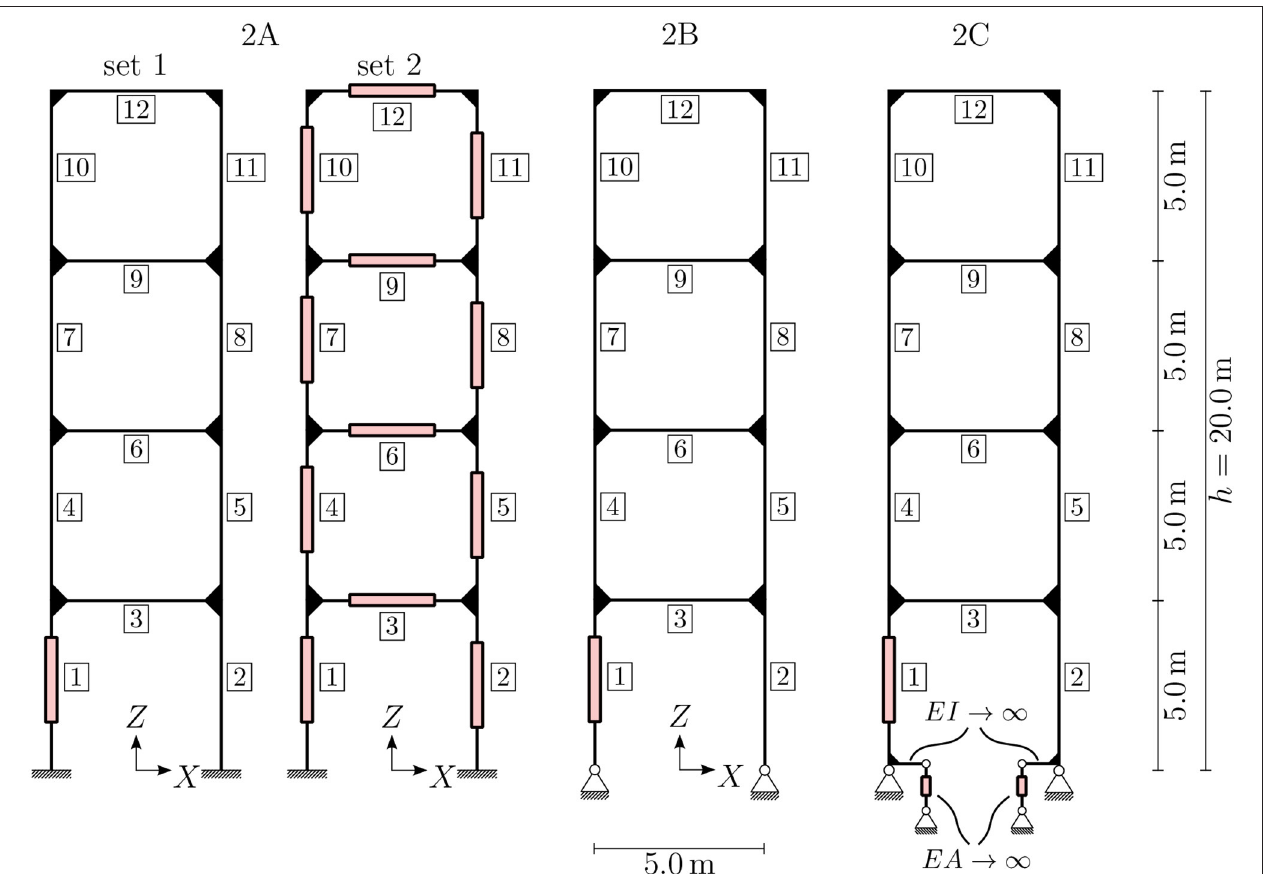
FIGURE 6 | Example 2, frame design: investigated variants with dimensions and actuator